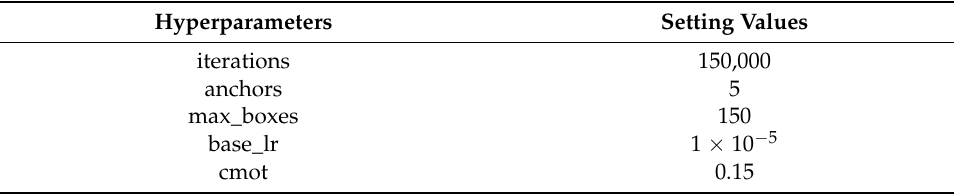
Table 2. The setting values of